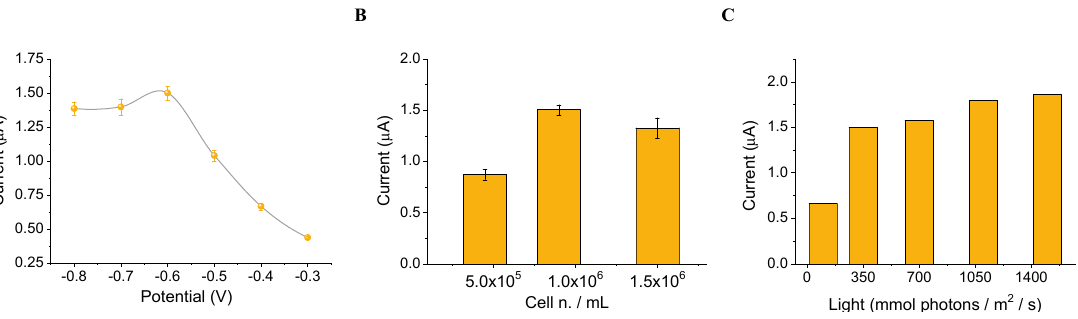
Figure 5. ( A ) Current intensity vs. applied potential. ( B ) Current intensity vs. immobilized cell number. ( C ) Current intensity vs. light intensity.